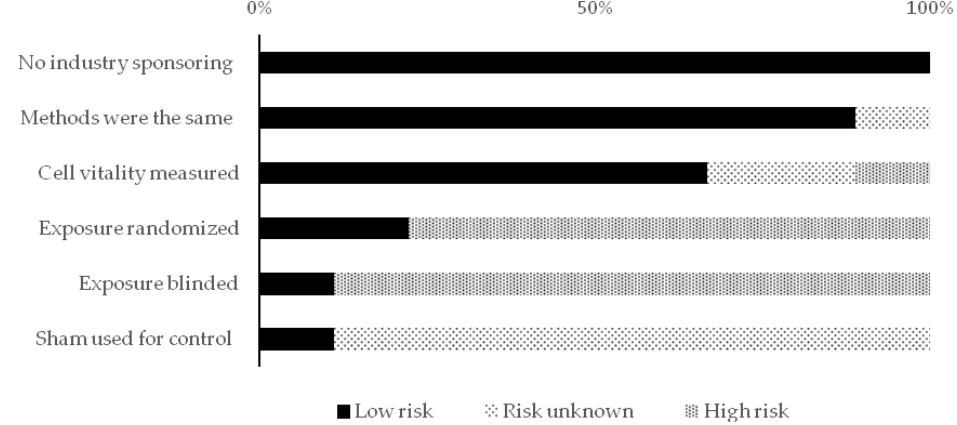
Figure 2. Reporting quality scores in all the included studies ( n = 12) presented in percentages of articles (% of total).